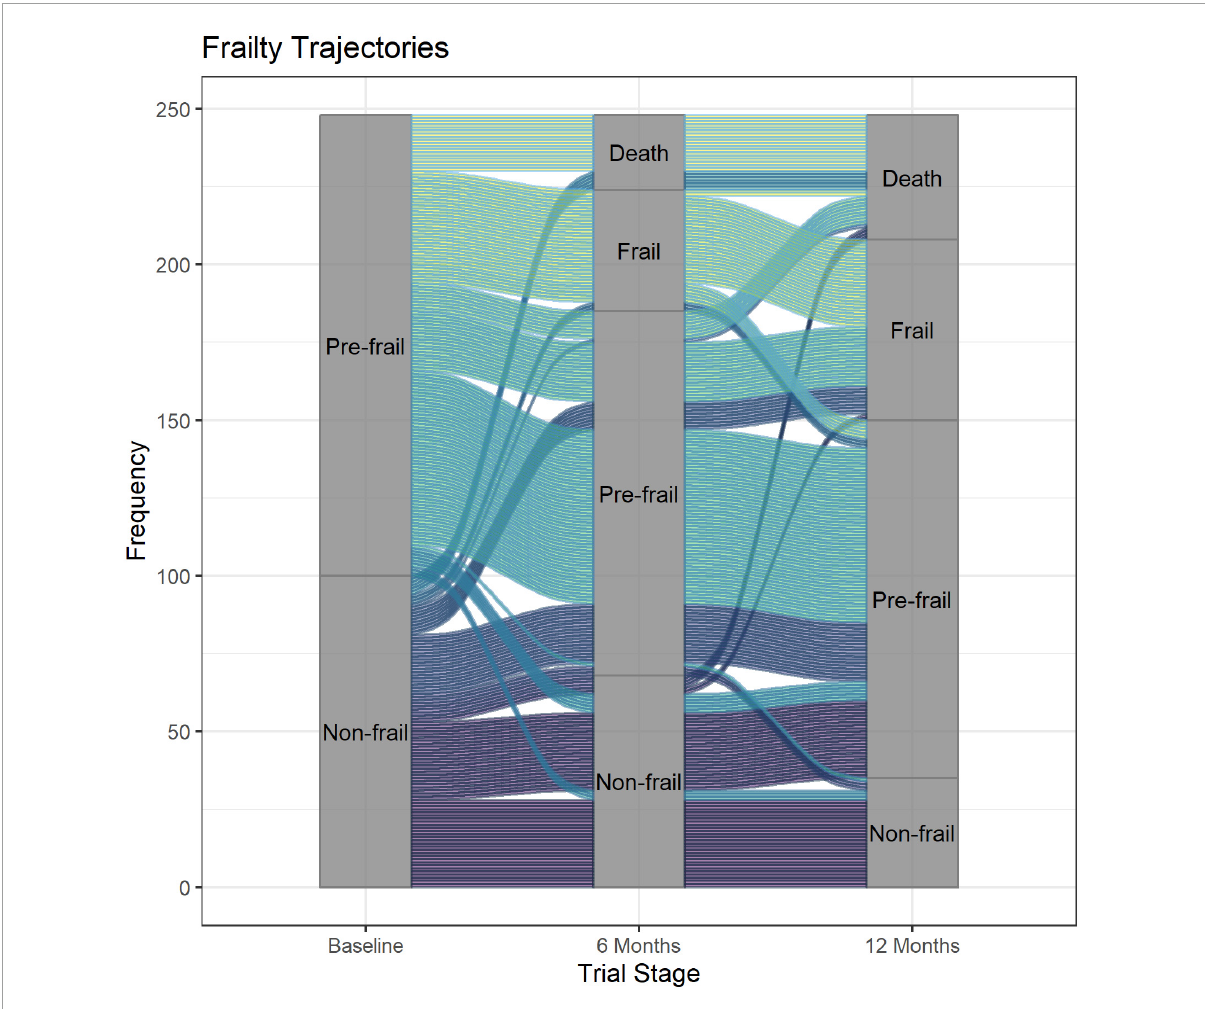
FIGURE3 Frailty trajectory over 12 months for all study